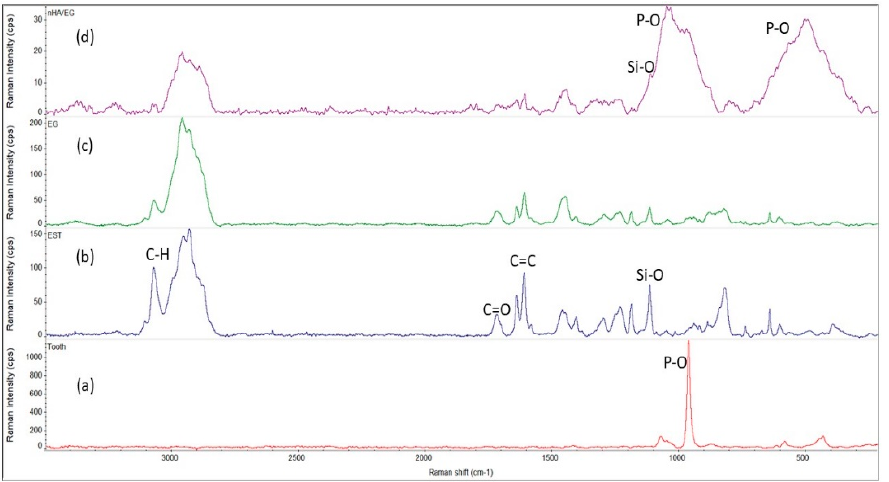
Figure 2. Comparative Raman spectra of ( a ) tooth, ( b ) EST, ( c ) EG, and ( d ) nHA/EG. The character- istic stretching P-O peak appeared at 963 cm − 1 . The glass-fiber-based retainers showed stretching C- H peaks (3100–2800 cm − 1 ), C=O (1724 cm − 1 ), aliphatic (164 cm − 1 ), aromatic (1610 cm − 1 ), and Si-O (1120 cm − 1 ). The nHA/EG showed the presence of phosphate peaks.